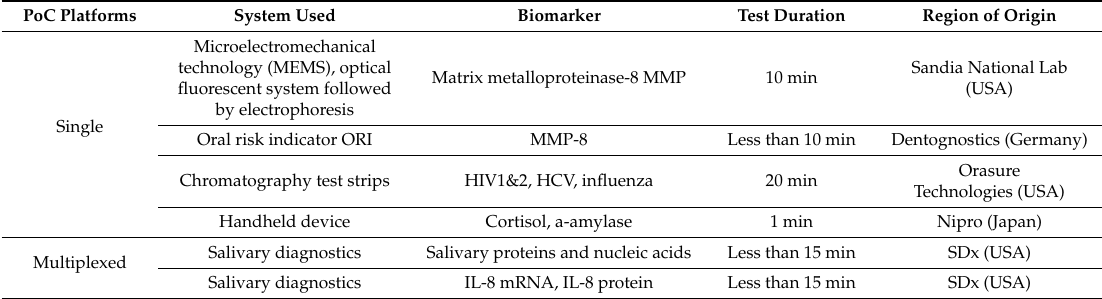
Table 3. Examples of single and multiplexed salivary biomarker-based PoC diagnostics [9]. PoC